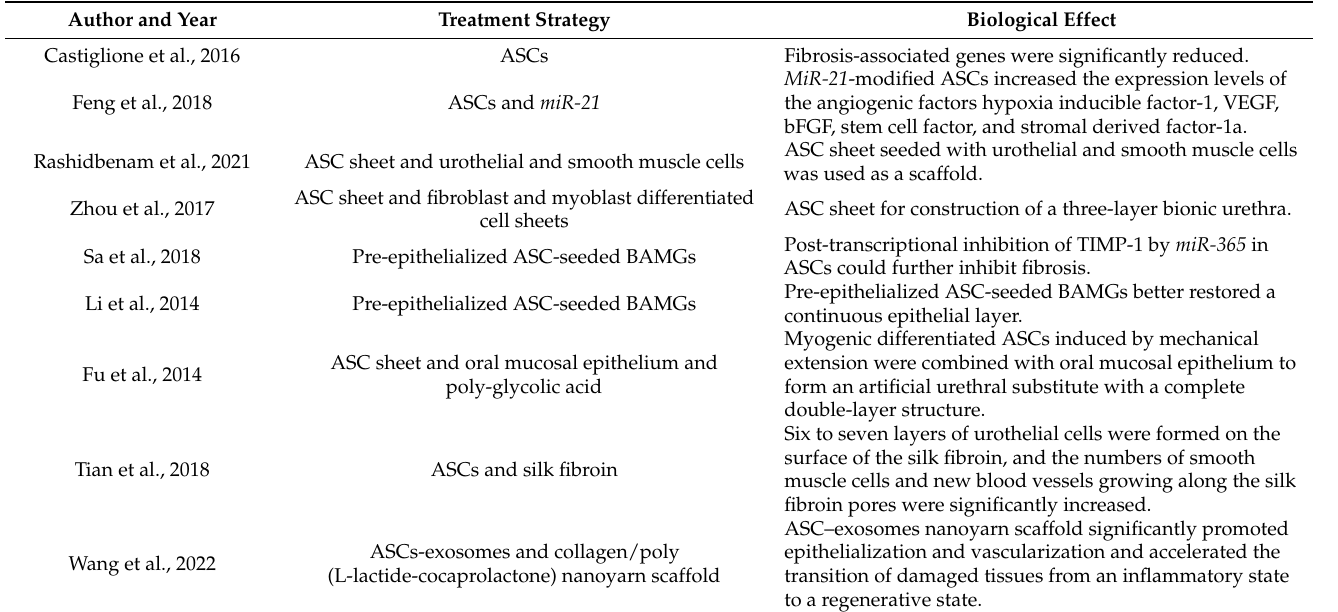
Table 2. Overview of ASC-based therapy for urethral